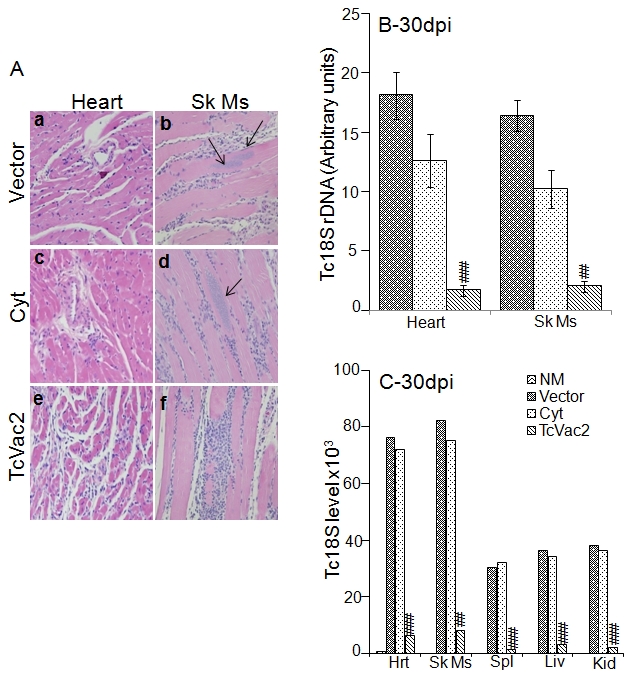
Enhanced infiltration of inflammatory infiltrate contributed to control of acute tissue parasite burden in TcVac2-immunized mice.Mice were vaccinated with TcVac2 or given vector or cytokines (cyt) alone, and challenged with T. cruzi. (A) Shown are H&E staining (blue-nuclear and pink-muscle/cytoplasm/keratin) of heart tissue and skeletal muscle (Sk Ms) sections at day 30 pi (magnification: 20X). Arrows mark parasite nests in panels b & d. (B&C) Total DNA from Heart (Hrt), Skeletal Muscle (Sk Ms), Spleen (Spl), Liver (Liv) and Kidney (Kid) was isolated and used as a template for the amplification of T. cruzi 18SrDNA sequence by traditional PCR (B) or real time PCR (C). Standard deviation was <12% for the data presented in the Figure 5C (##
p<0.01, ###
p<0.001).